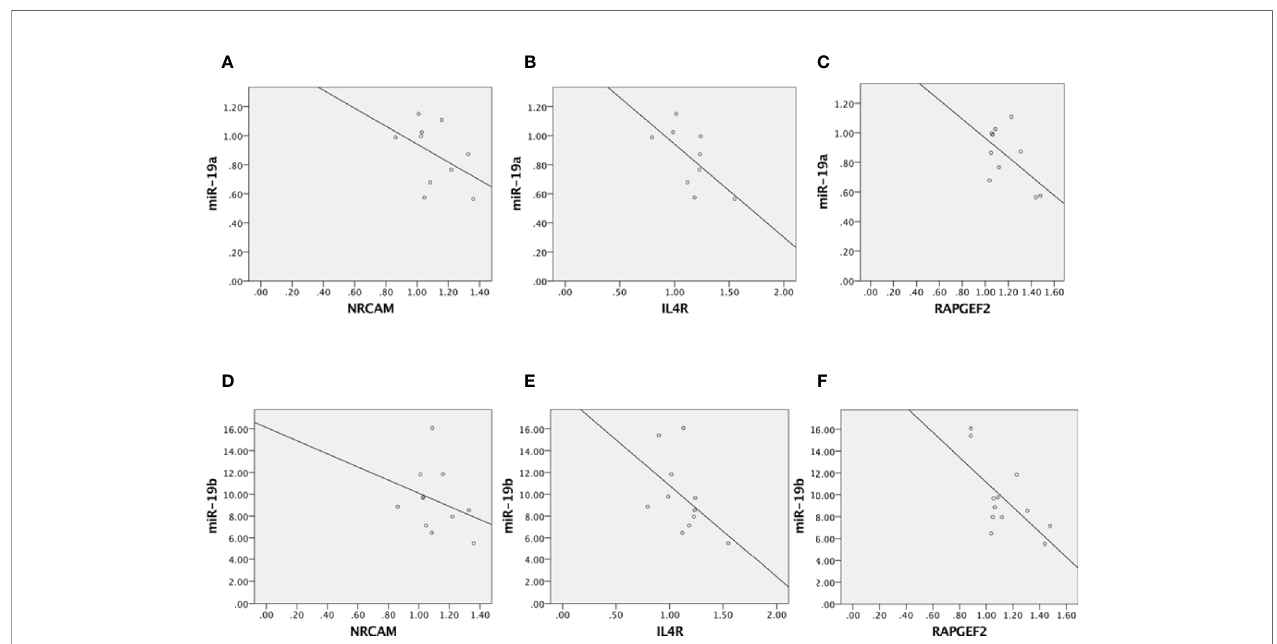
FIGURE 4 | Correlation analyses between miR-19a and NRCAM (A) , miR-19a and ILR4 (B) , miR-19a and RAPGEF2 (C) , miR-19b and NRCAM (D) , miR-19b and ILR4 (E) , and miR-19b and RAPGEF2 (F)